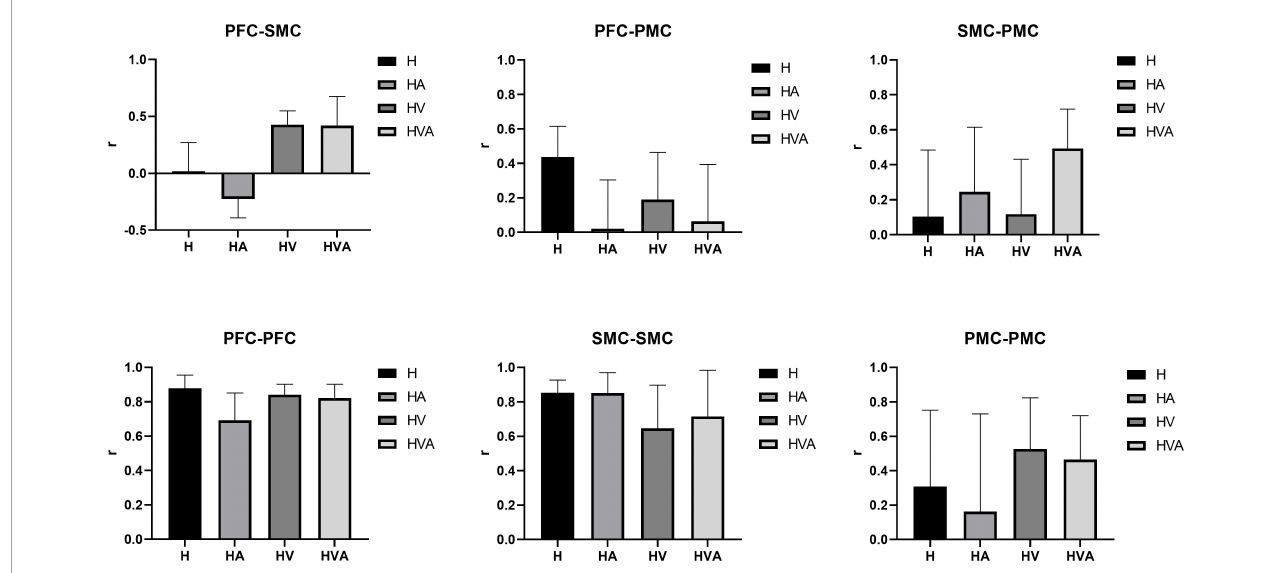
FIGURE10 Statistical analysis of the correlation coefficients (r) under four experimental conditions between different regions of interest (ROIs). The ROIs include the bilateral dorsolateral prefrontal cortex (PFC, channels 8–12), somatosensory area (SMC, channels 14, 15, 17, 19–21, and 23), and premotor cortex (PMC, channels 13, 16, 18, 22, and 24). The abbreviations in the figure represent haptic (H), haptic + auditory (HA), haptic + visual (HV), and haptic + visual + auditory